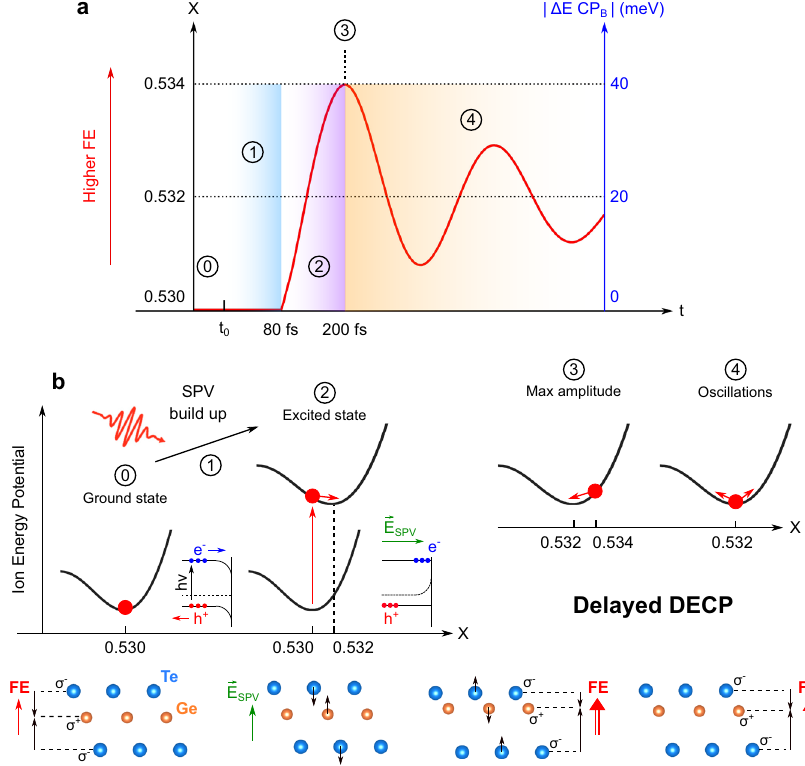
Fig.4|IllustrationofthedelayedDECPmechanism.a Schematicevolutionofthe temporal evolution of the x position of the Te atom in the primitive unit cell of α - GeTe(111) and the correspondingvariation of the positionof CP B as measured with ARPES. The fi ve steps of the mechanism are numbered from ⓪ to ④ . b Evolution of